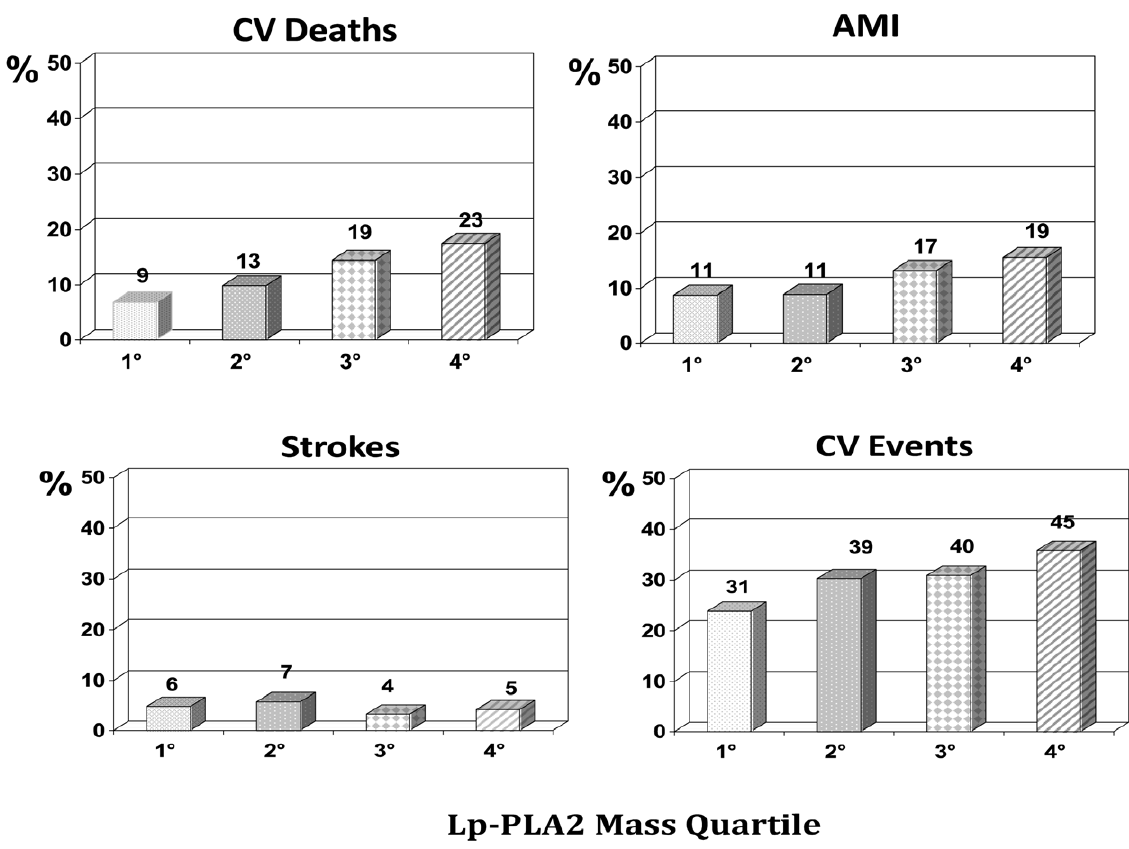
Figure 2. Cardiovascular events by Lp-PLA2 mass. The bar graphs show cardiovascular death and events rate by quartiles of Lp-PLA2 mass (the absolute number of events is shown above each column). Cardiovascular deaths (p=0.020) were significantly different across Lp-PLA2 mass quartiles. AMI: acute myocardial infarction.